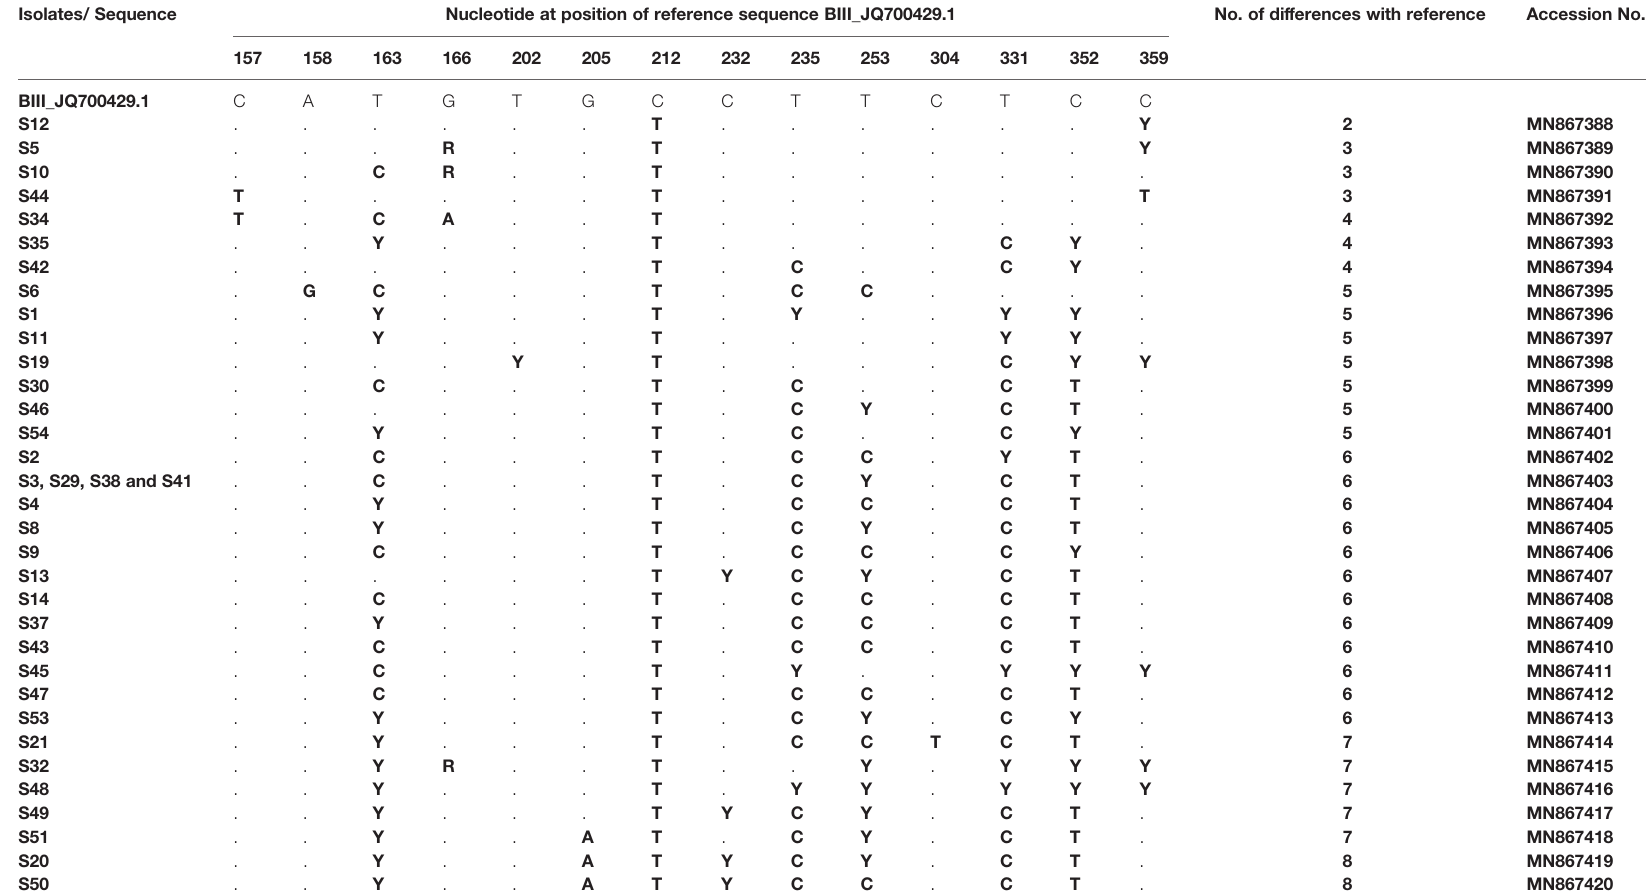
Nucleotide substitutions are in bold and in capital letters, dots indicate identity to the reference sequence (BIII_JQ700429.1), heterozygous positions are in bold and indicated by standard IUPAC codes (Y: T/C and R: